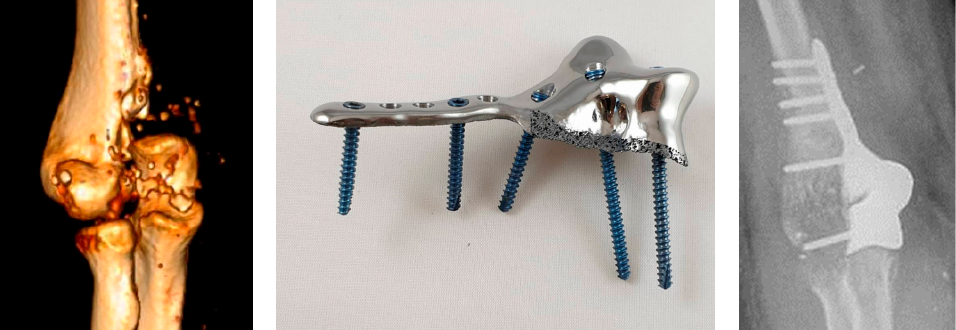
Figure 3. A CT reconstruction visualizing the completely comminuted medial part of a distal humerus with a critical size bone defect (left) together with a 3D printed custom-made prosthesis designed for the distal humerus defect (middle) and an x-ray of its implantation (right).